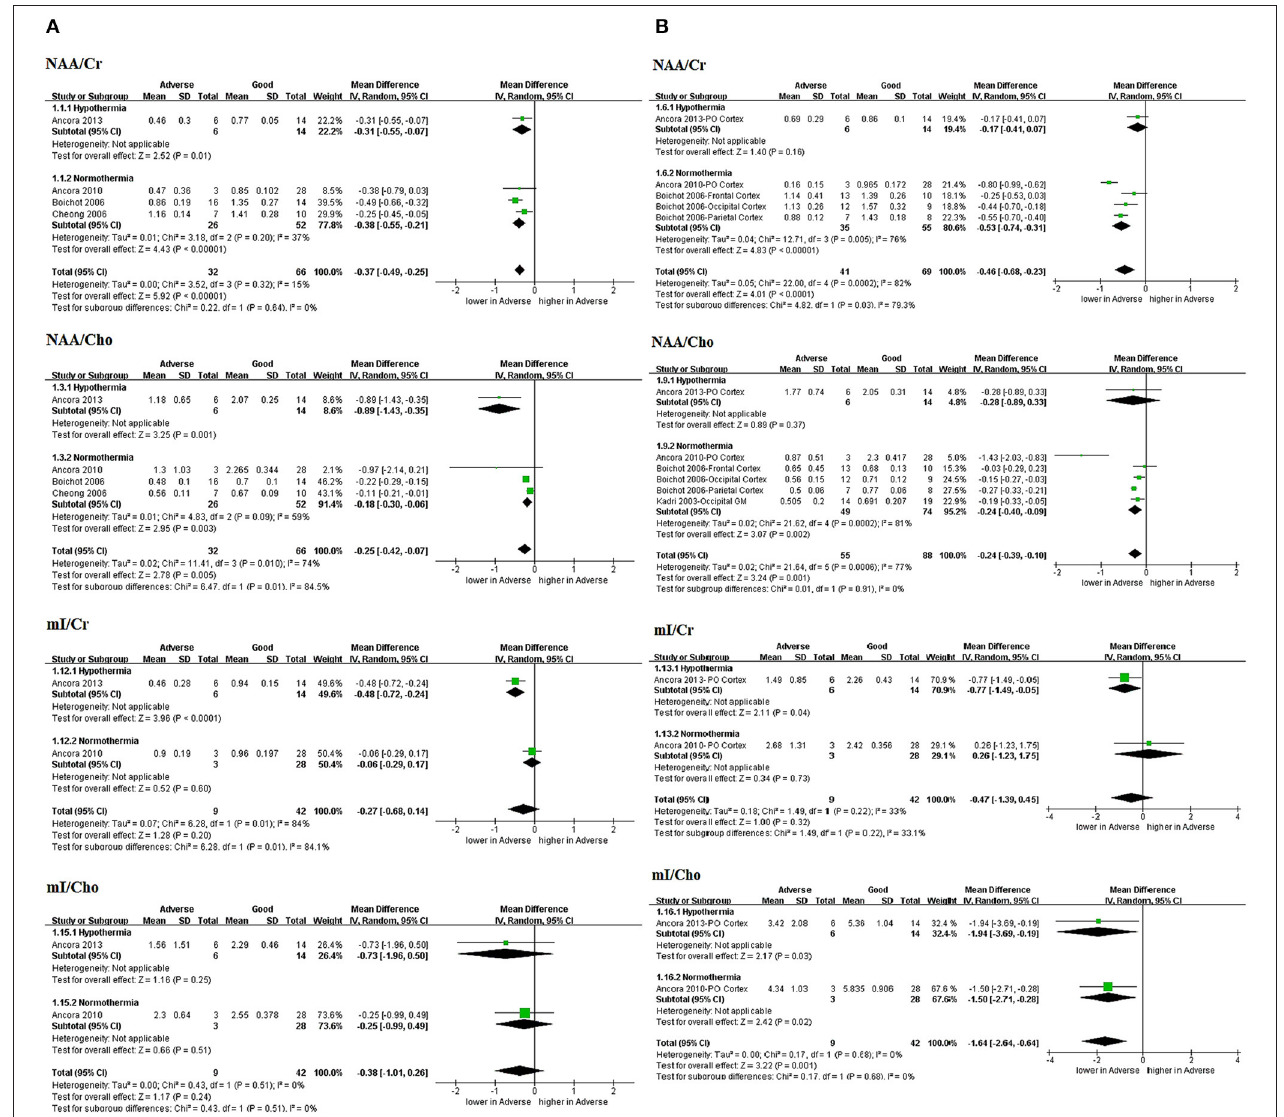
FIGURE 3 | Graphic depiction of the results of meta-analyses: peak area ratios in the (A) BG/T and (B) cerebral cortex (NAA/Cr, NAA/Cho, mI/Cr, and mI/Cho). BG/T, basal ganglia or thalamus; Cho, choline; Cr, creatine; mI, myo-Inositol; NAA,